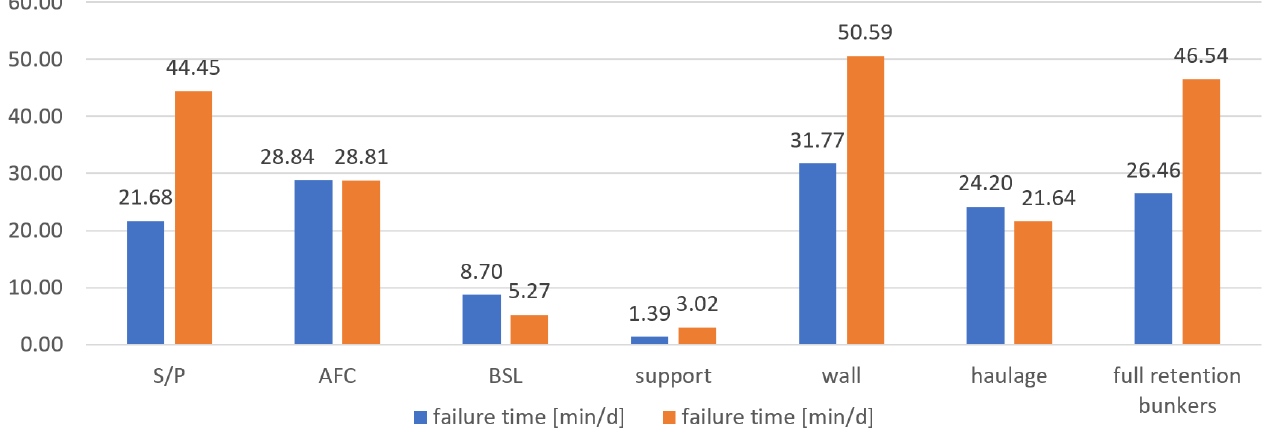
Figure 13. Comparison of the total duration of failures per one day of longwall operation.